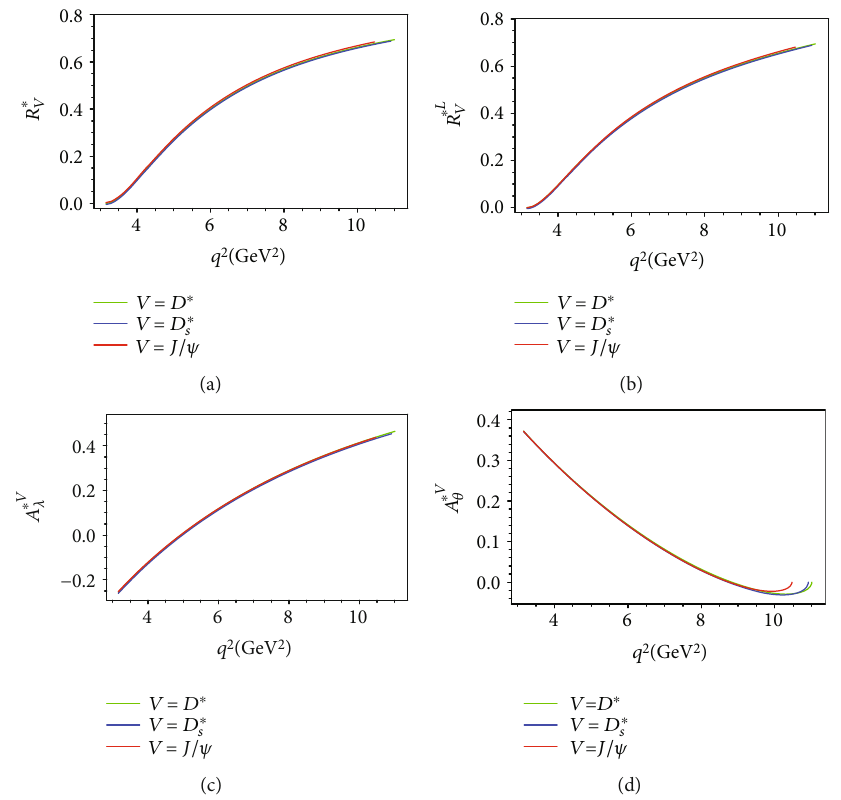
ð q 2 Þ , A ∗ V ð q 2 Þ , and A ∗ V θ V